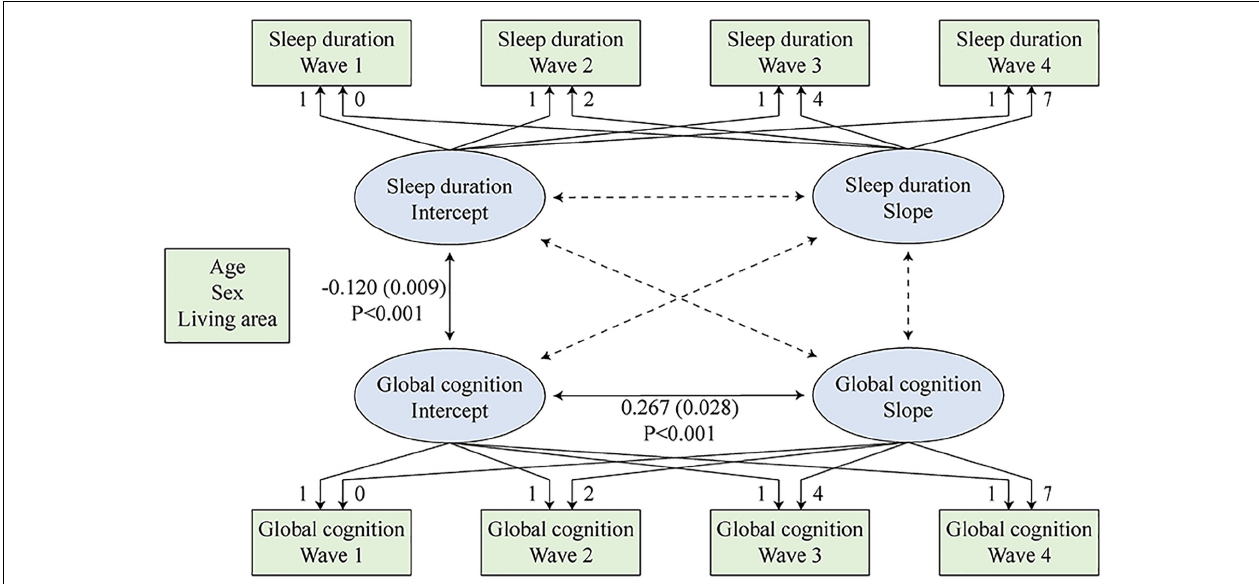
FIGURE 2 | Combined latent growth models of sleep duration and global cognition. Sleep duration intercept, sleep duration slope, global cognition intercept, and global cognition slope were regressed on the covariates simultaneously.